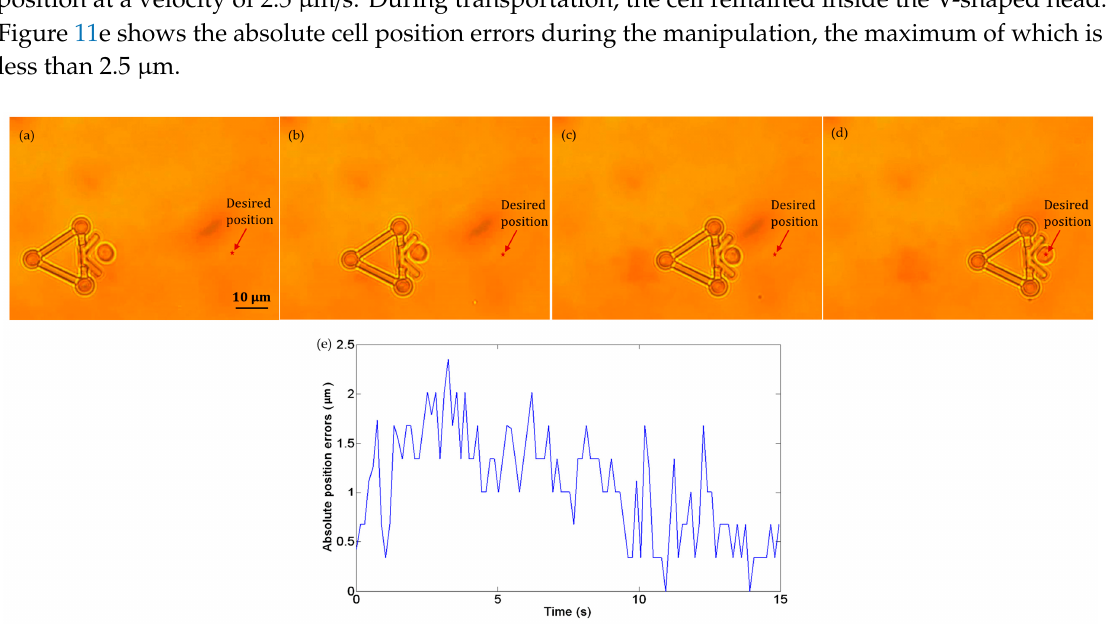
Figure 11. Experiments of cell transport without obstacles in the workspace. ( a ) t = 0 s: the cell in the initial position. ( b ) t = 5 s: the cell in transport. ( c ) t = 10 s: the cell in transport. ( d ) t = 15 s: the cell was successfully transported to the desired position. ( e ) Absolute position errors of the cell in transport.